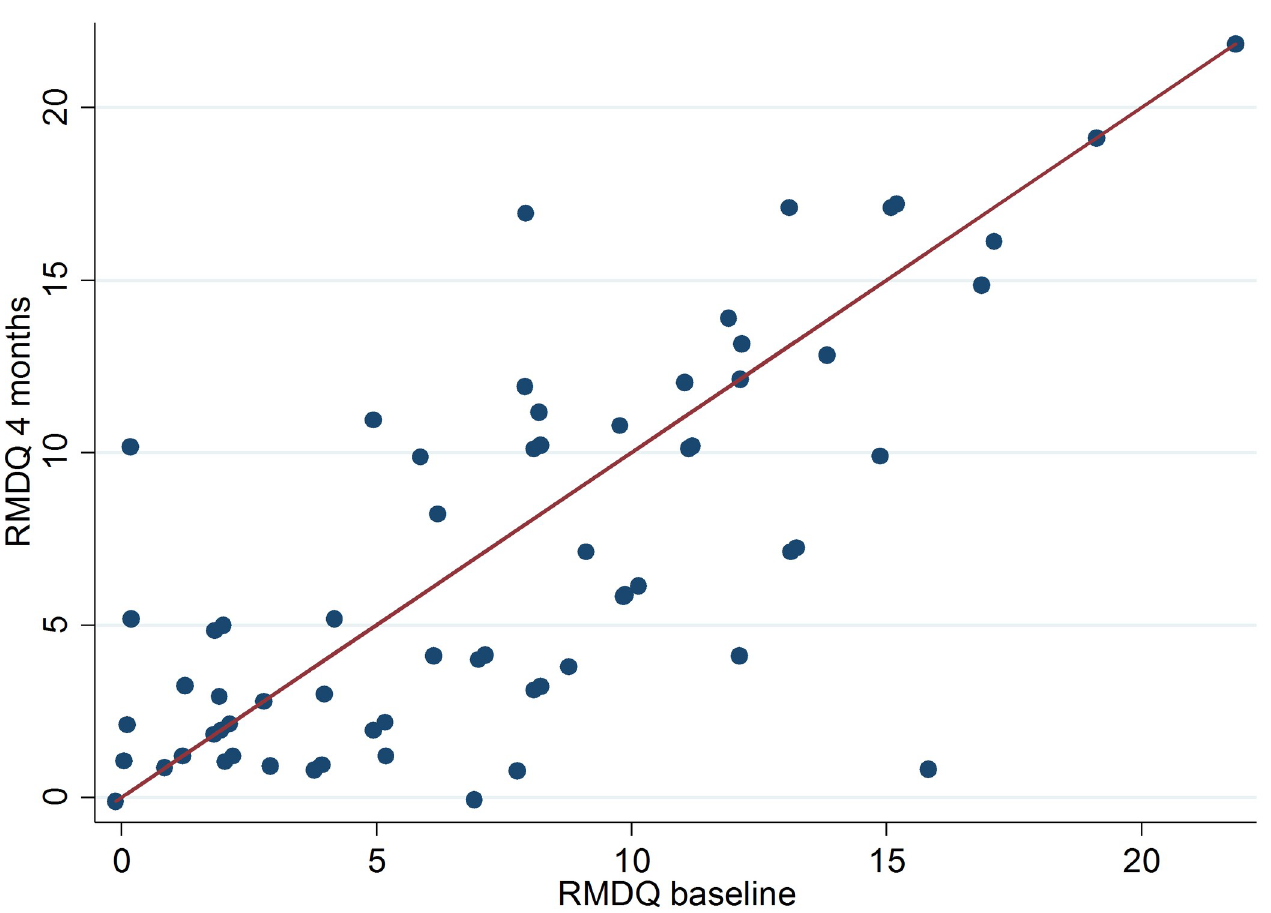
Fig 4. Scatter plot of the RMDQ scores at baseline and after 4 months in the intervention group in patients with a positive referral advice.